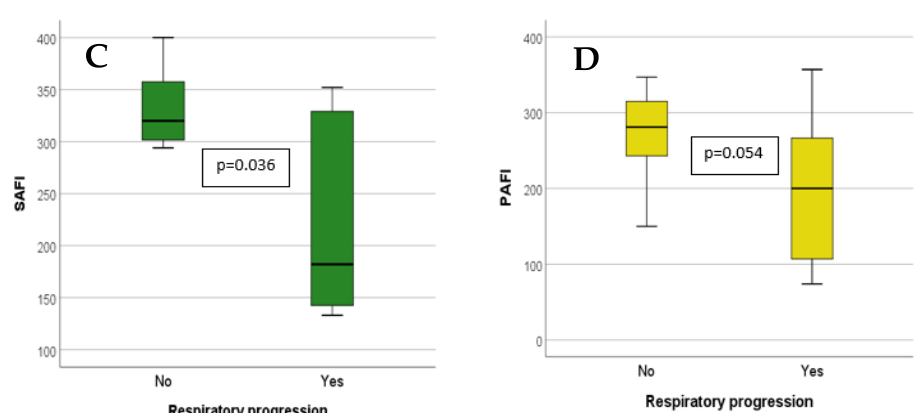
Figure 2. Quantitative variables value at time of sotrovimab infusion in patients with and without respiratory progression. The bar limits represent the interquartile range (p25 and p75). The black line within the bar represents the median. The lines that are external to the bar represent range (minimum–maximum). Comparison was made by means of Mann–Whitney’s U. A: Days since symptoms onset; B : RT-PCR cycle threshold; C: SaFi; and D: